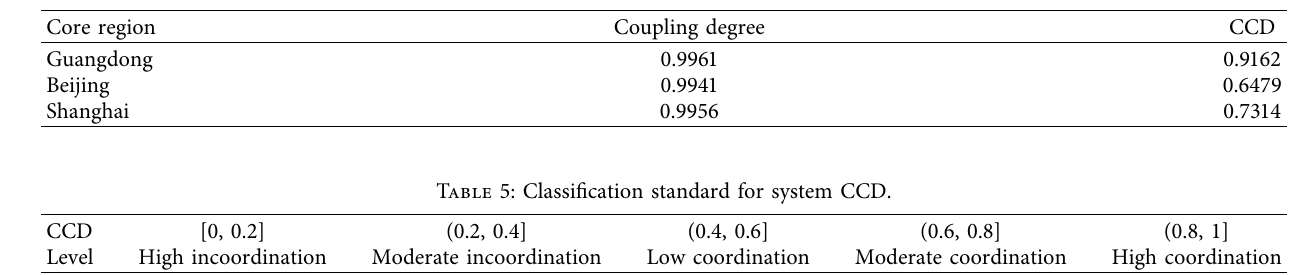
Table 4: CCD of the PEI of the high-tech industry in each region.